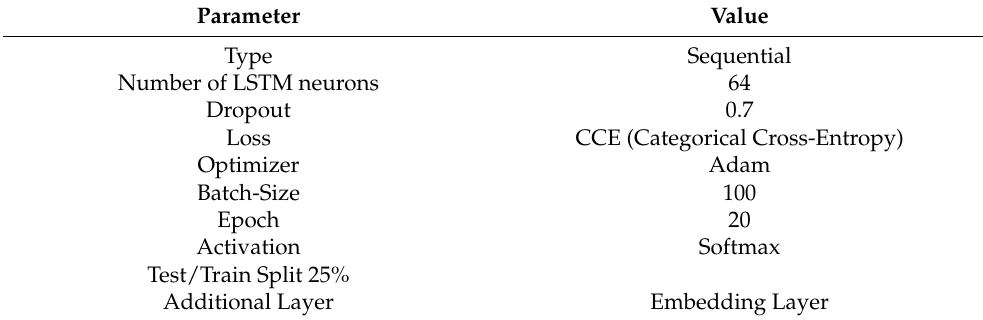
Table 9. LSTM configuration.